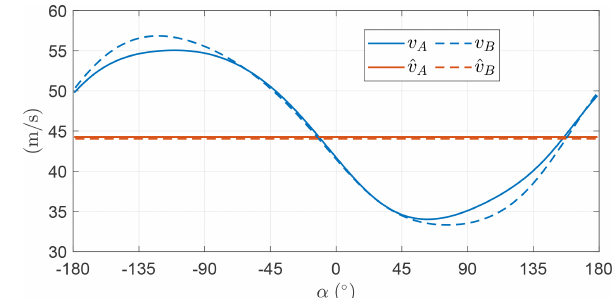
Figure 37. Optimal power production P as function of the angular position.